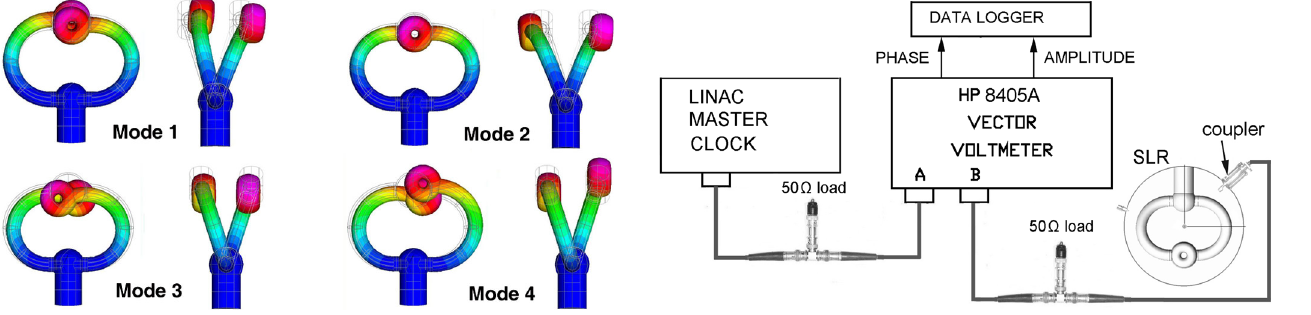
FIG. 3. The four lowest mechanical modes in SLR identified using Strand7.